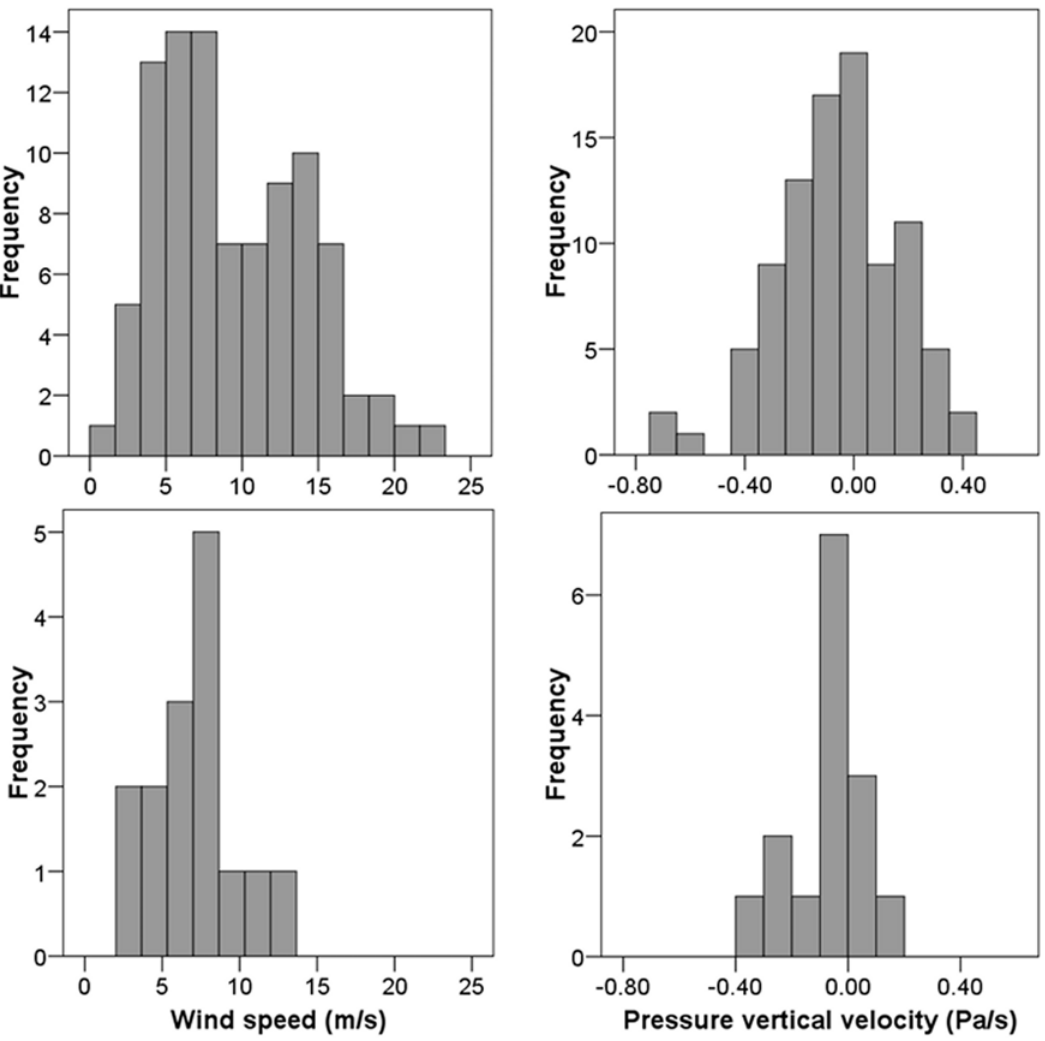
Figure 5. Frequency histograms for wind speed and pressure vertical velocity. The top graphs show the atmospheric conditions from the North American Regional Reanalysis Model [21] for 1–31 May, 2003–2005, at the 925 mb level at 0300 UTC (2100 local time) over the site where our thrushes were captured and released. The bottom graphs show the atmospheric conditions encountered by the 15 Swainson’s thrushes in this study.